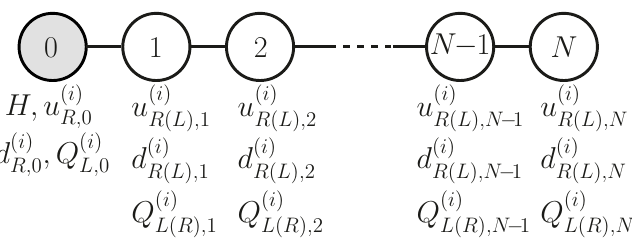
Figure 8 . The \universal N " limit of the clockwork setup, where all the clockwork chains are of the same length, N , and the hierarchy of the SM quark masses comes entirely from di(cid:11)erent values of the clockworking factors, q , see also eq.